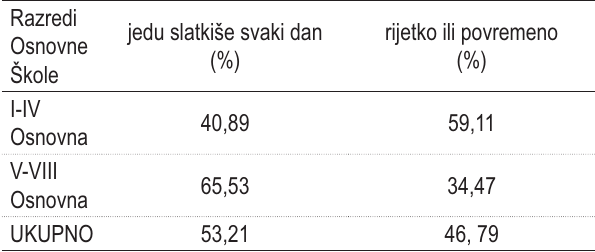
TABELA 4. Distribucija uwestalosti uzimanja slatkiša